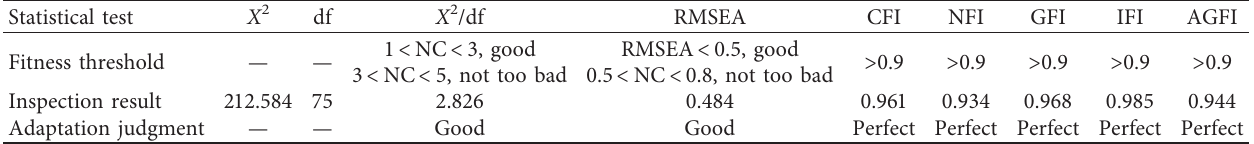
Table 2: Evaluation results of the modified